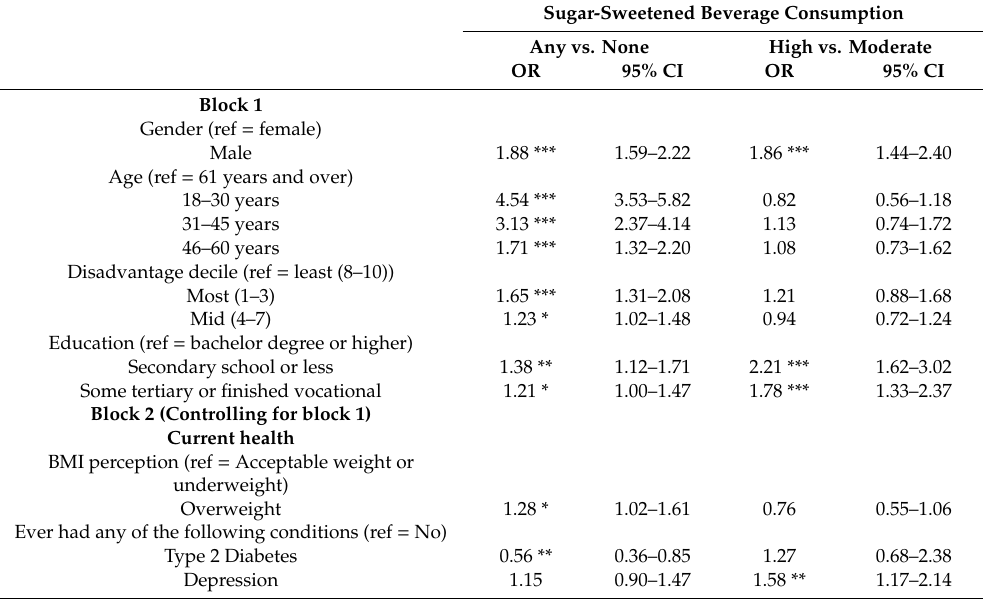
Table 2. Hierarchical logistic regression analyses examining demographic, health, behavior, and environmental predictors of past week sugar-sweetened beverages